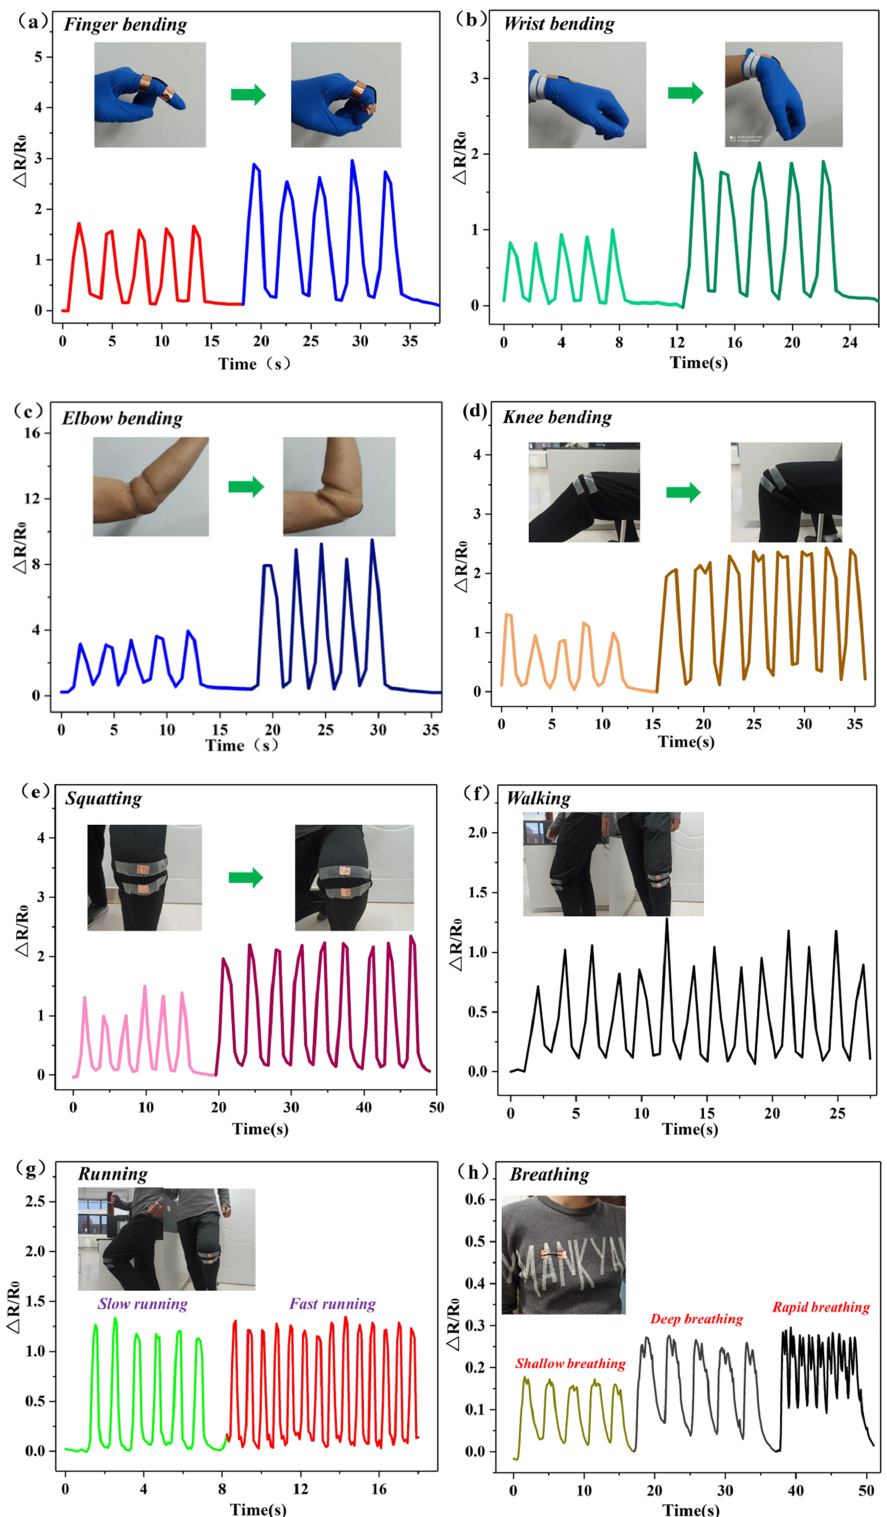
Figure 8. Monitoring of human motions using flexible strain sensors: the responses to human motions of ( a ) finger bending, ( b ) wrist bending, ( c ) elbow bending, ( d ) knee bending, ( e ) squatting, ( f ) walking, and ( g ) running, and ( h ) the responses to breathing.